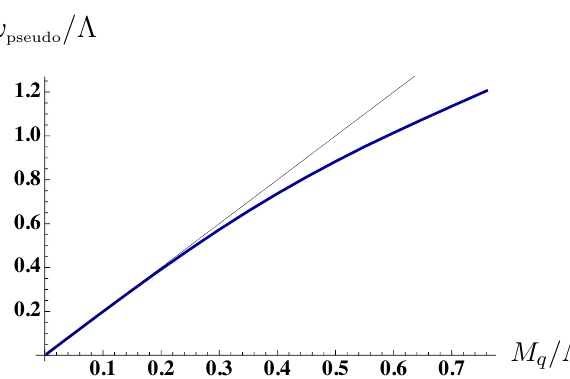
Figure 4. Mass of the pseudo-Goldstone mode. The thin, black line corresponds to the relation ! = 2 M q pseudo